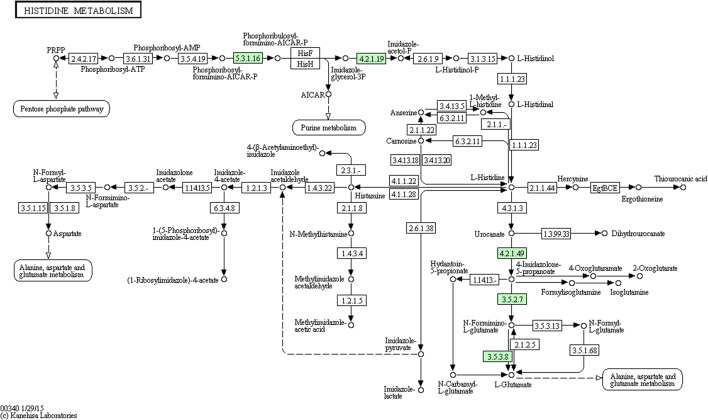
Protein expression profiles during biofilm formation following treatment with cefquinome mapped onto the histidine metabolism pathway. Changes in proteins are marked in green and mapped onto KEGG pathways.